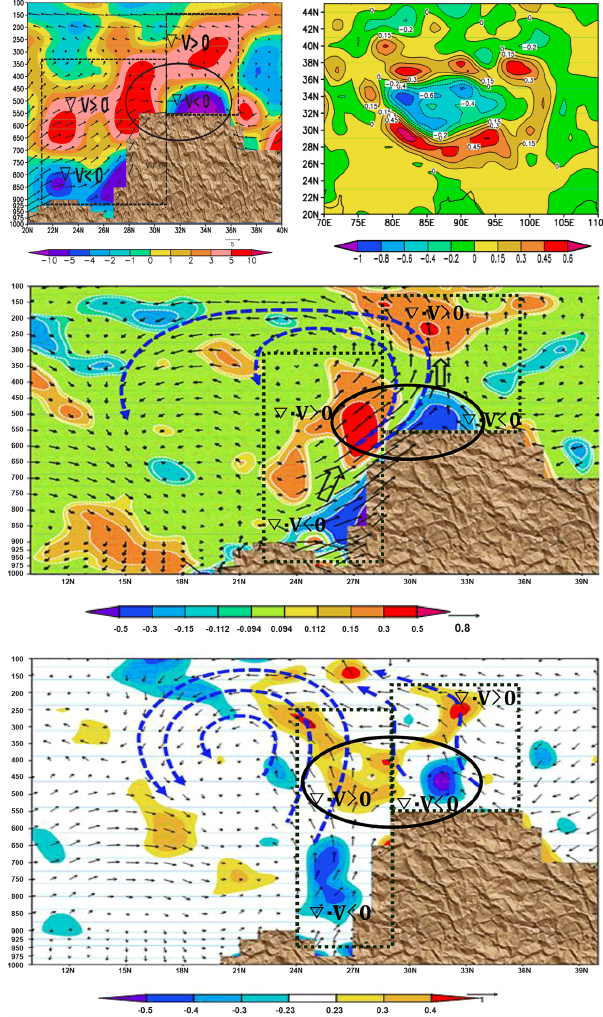
contours) for summer averaged over 2000–2009 along 93–94 ◦ E (left upper panel); Distribution of summertime 500hPa divergence averaged over 2000–2009 (right upper panel). Vertical sections of the correlations of the daily TP heat source column Q 1 to the di- vergences (filled contours) and the correction vectors of daily Q 1 to V - and W -wind components in July 2000–2009 along 93–94 ◦ E with the meridional circulations and the uplifting vapor transport denoted by blue dash lines and black arrows, respectively (middle panel). Vertical sections of the lag-correlations of TP heat source column Q 1 at 10 prior days to divergences and the lag-correlation vectors in the meridional circulations in July 2000–2009 along 93– 94 ◦ E (lower panel). In all panels, two couplings of lower conver- gence zones (LC) and upper divergences (UD) are denoted with ∇· V <0 and ∇· V >0 in two dotted rectangles and the interaction of LC in the TP and UD over the southern slopes in the black ovals. The plateau section is marked with soil